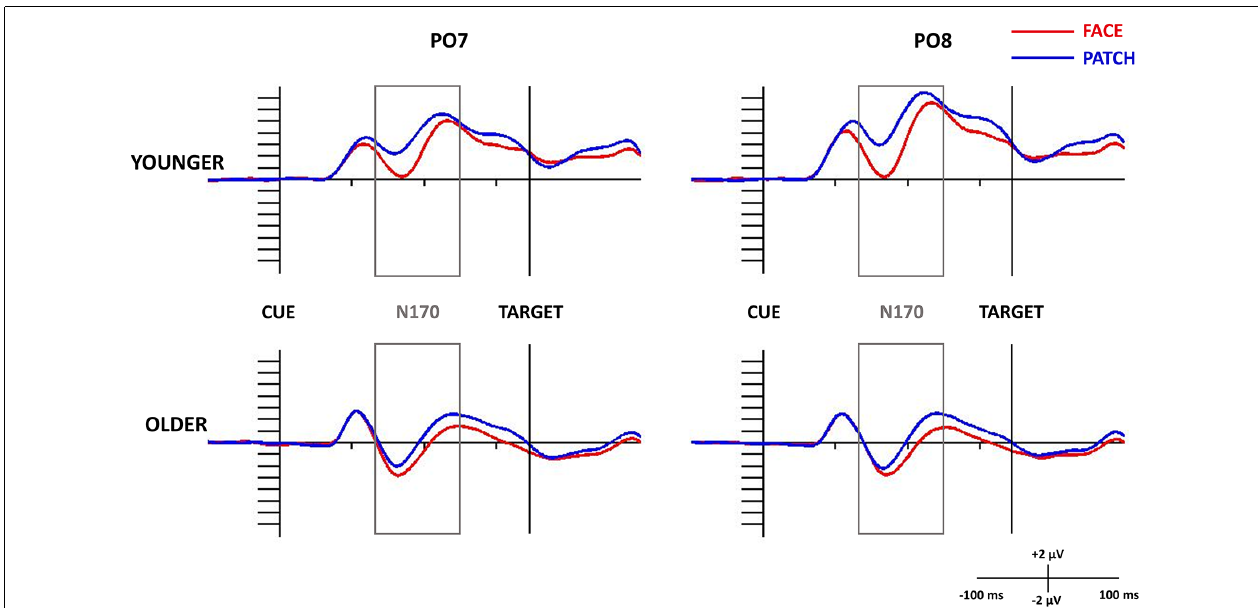
FIGURE 2 | N170 component for task-irrelevant faces and patches in the study phase at the PO7 (left side) and PO8 (right side) electrode sites in younger (top panel) and older adults (bottom panel). The 0 ms time point on the x-axis is locked to the centrally gazing cue presentation and it represents the ( − 100, 500 ms) interval. ERPs for faces are shown in red, and patches in black. The gray rectangle shows the 130–250 ms time window in which we searched for the N170 component.